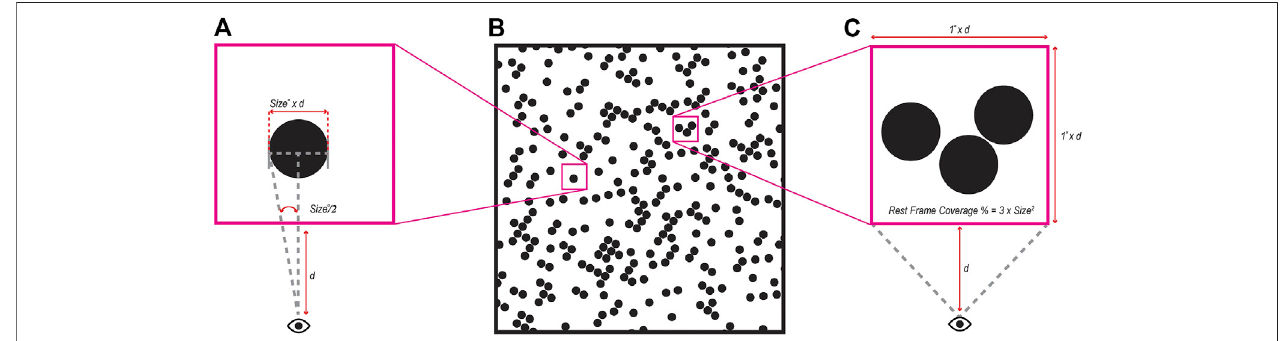
FIGURE3| Representationofthe9combinationsofGRFsdistributionusedinouruserstudy.Notethatthetworedspheresoutsidethecutoutwouldnotbevisible by the FOV Restrictors technique.